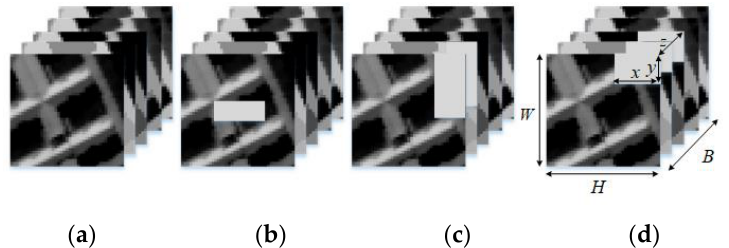
Figure 3. Examples of 3D random occlusion augmentation: ( a ) original (not occluded) inputs, ( b – d ) occluded inputs with occluded zones shown in grey.